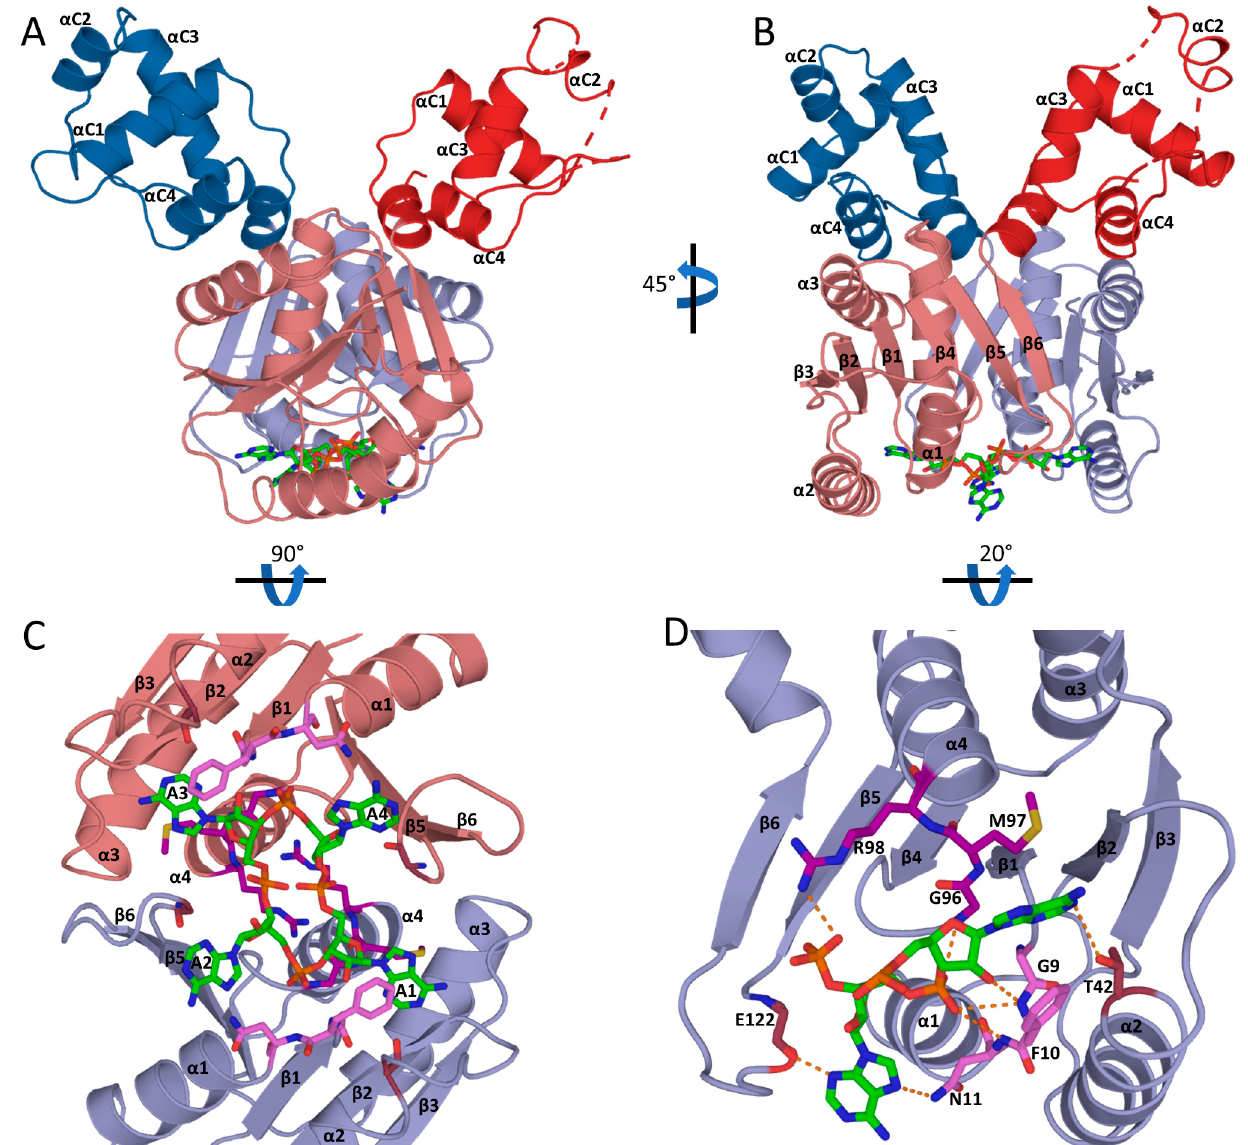
Figure 4. The Csa3a CARF domain binds cA 4 . ( A ) Ribbon diagram of the Csa3a dimer bound to cA 4 . The N-terminal CARF domains that form the cA 4 binding pocket are colored light red/blue, the C-terminal wHTH domains are colored dark red/blue and cA 4 is shown in a stick representation with C atoms colored green. A single cA4 molecule is bound in the twofold symmetric ligand binding site, across the dimer interface of the CARF domain. ( B ) The cA 4 -bound Csa3a dimer rotated 45° about the vertical axis shows the location of cA 4 in the binding pocket relative to secondary structural elements in chain B (red). ( C ) Ribbon diagram of the cA 4 -bound Csa3a dimer looking into the cA 4 binding pocket. Relative to A, the structure is rotated 90° about the horizontal axis. Motif 1 (pink), motif 2 (purple), T42 (deep red) and E122 (deep red) which make direct interactions with cA 4 are represented as sticks. ( D ) Ribbon diagram of a single Csa3a subunit bound to bases 1–2 of cA 4 . The structure is rotated − 20° about the horizontal axis relative to B. Hydrogen bonds are shown as orange dashes.